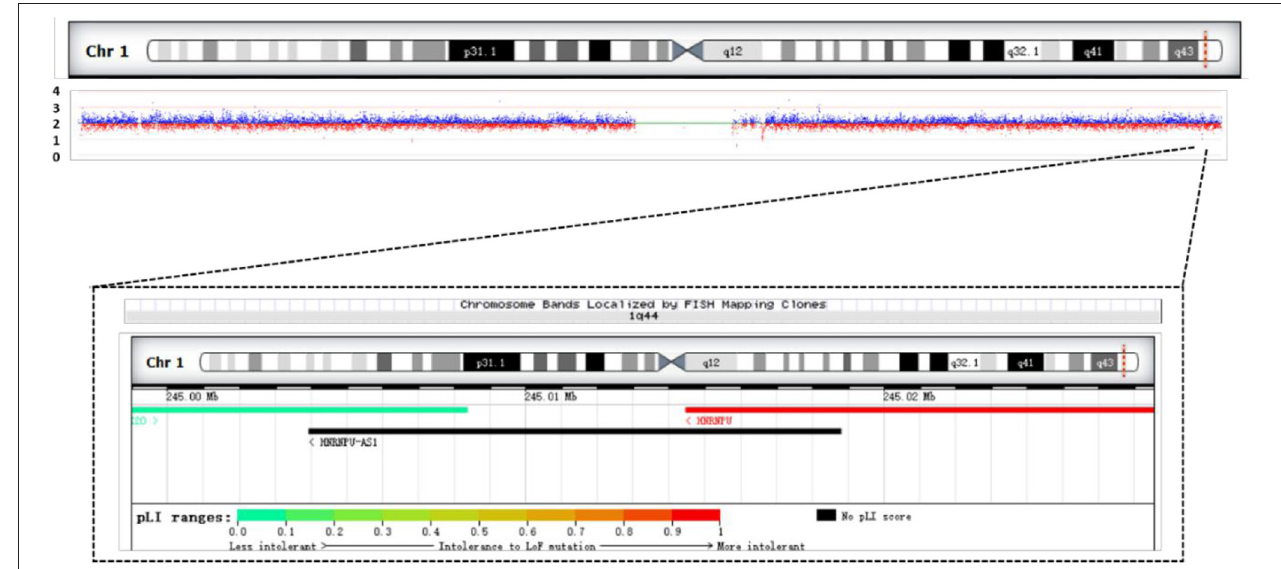
FIGURE 4 | Results of CNV analysis based on exome trapping sequencing depth in the patient. It shows a 28.7KB heterozygous deletion (chr1:244999016-245027609, hg19) in the 1q44 region. Overview of patient’s chromosome 1 deletion and schematic diagram of the gene contained in the deletion region.